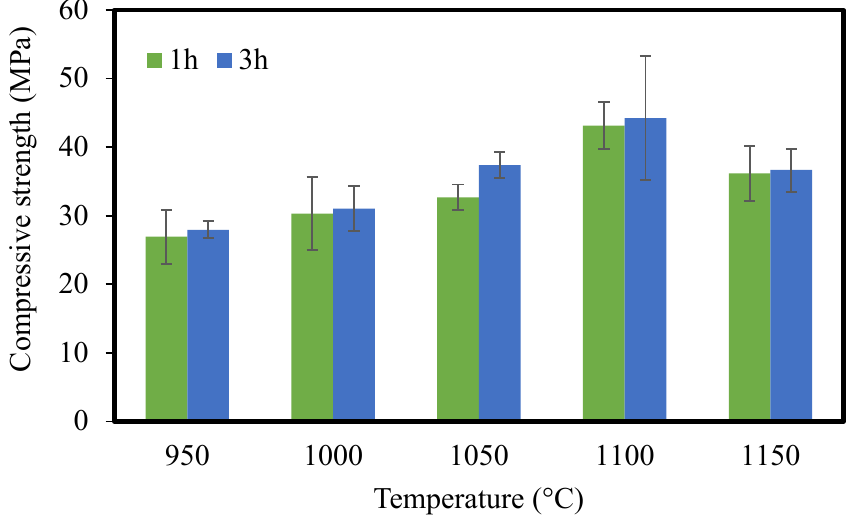
Figure 8. The compressive strength of CMs sintered at different temperatures for 1 and 3 h.